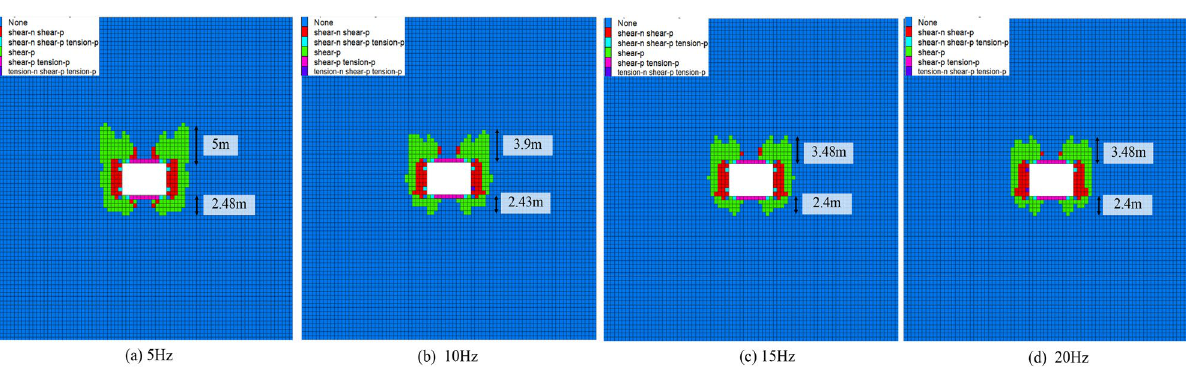
Figure 9. Failure of surrounding rock under different disturbance